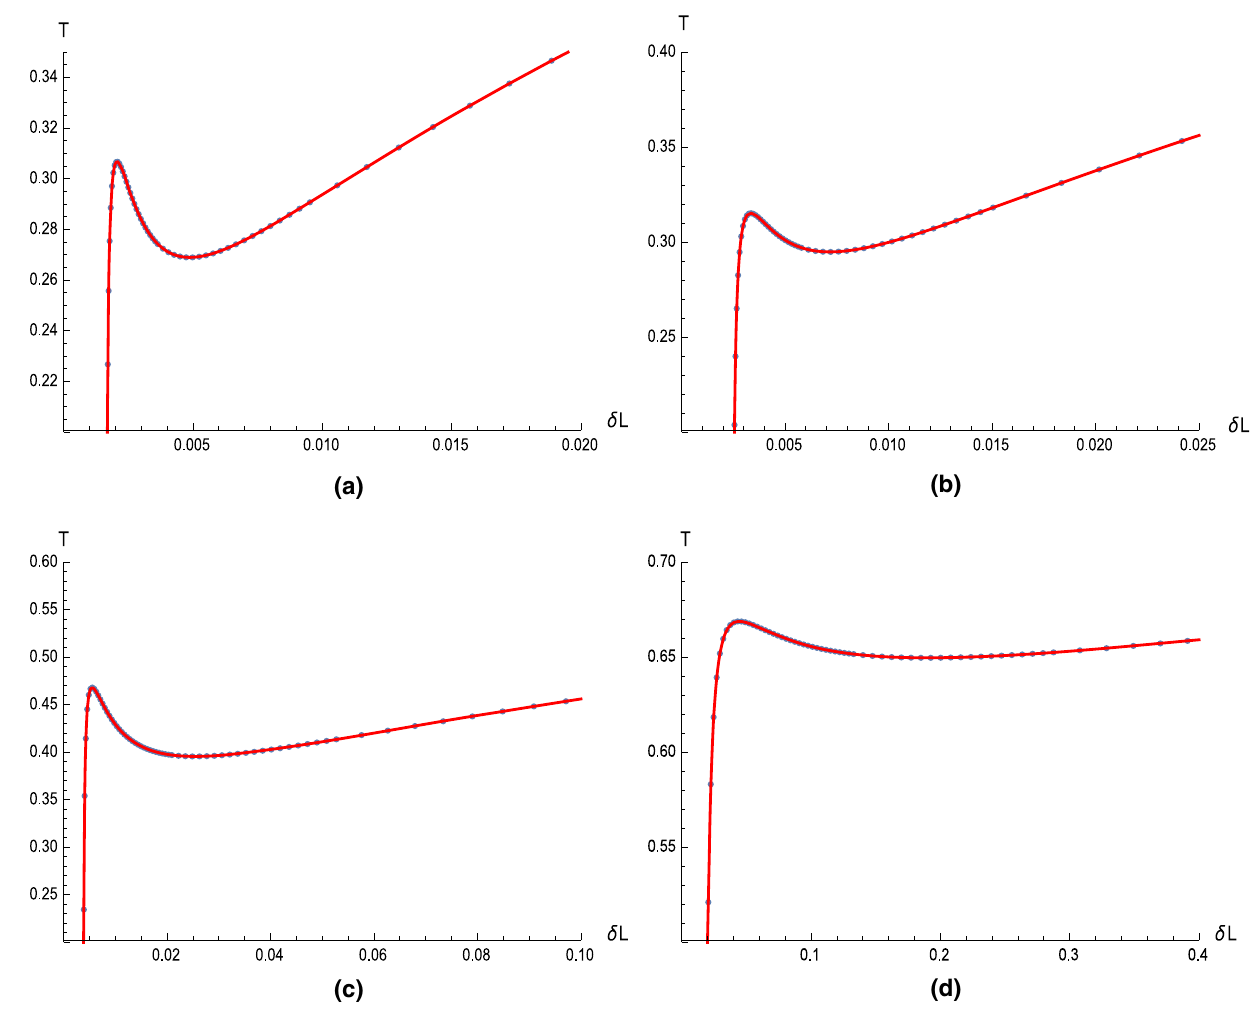
Fig. 3 T vs. δ L for n = 3 ,θ 0 = 0 . 3. a α = 0 , q = 0 . 12, b α = 0 . 25 , q = 0 . 12, c α = 0 . 5 , q = 0 . 06, d α = 0 . 75 , q = 0 .